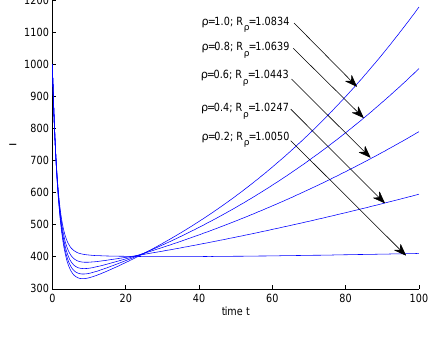
Figure 4. Profile of infectives as ρ changes, µ = 0 . 02 , p 1 = 0 . 5 , ν 1 = 0 . 6 , ν 2 = 0 . 7 , ǫ = 0 . 6 , b = 0 . 03 , σ = 0 . 09 , π = 10000 , d = 0 . 4 , β 1 = 0 . 4 , β 2 = 0 . 04 , β 3 = 0 . 3 , µ 0 = 0 . 001 , τ = 13 years, c = 1 , and q = 0 . 01